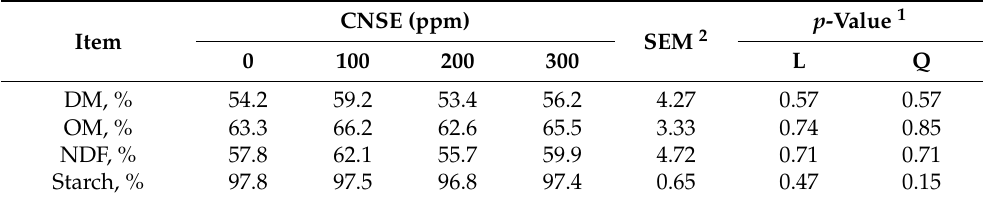
Table 4. Effect of different levels of CNSE supplementation on nutrient apparent digestibility from continuous